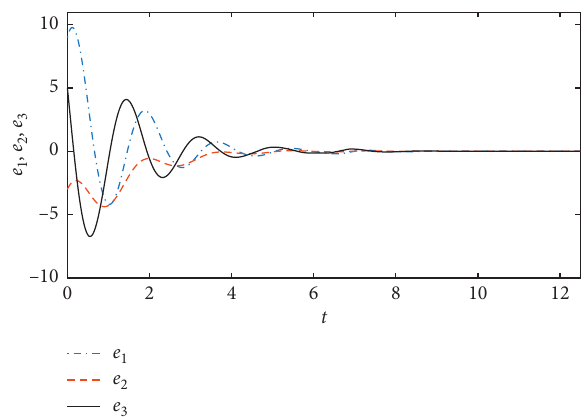
Figure 11: Finite-time error e slave